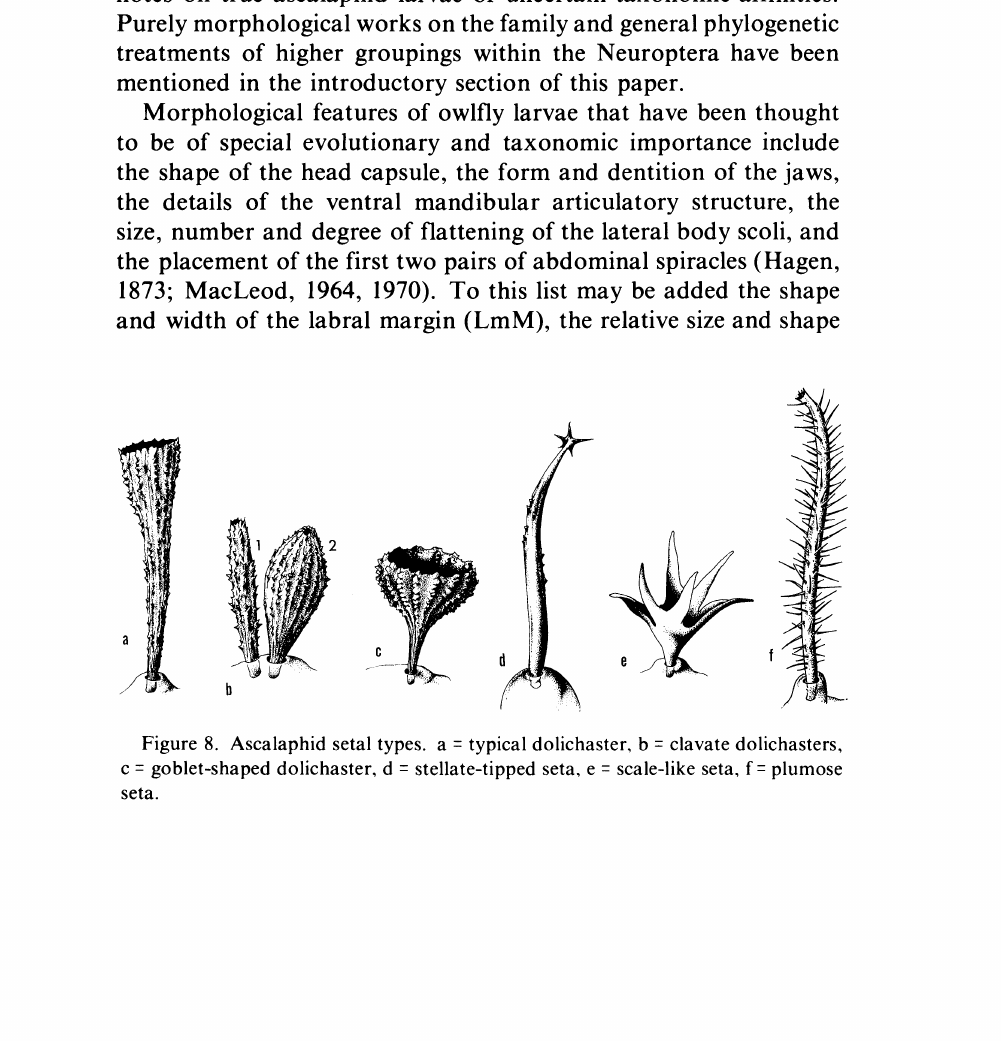
Figure 8. Ascalaphid setal types, a typical dolichaster, b clavate dolichasters, c goblet-shaped dolichaster, d stellate-tipped seta, e scale-like seta, plumose